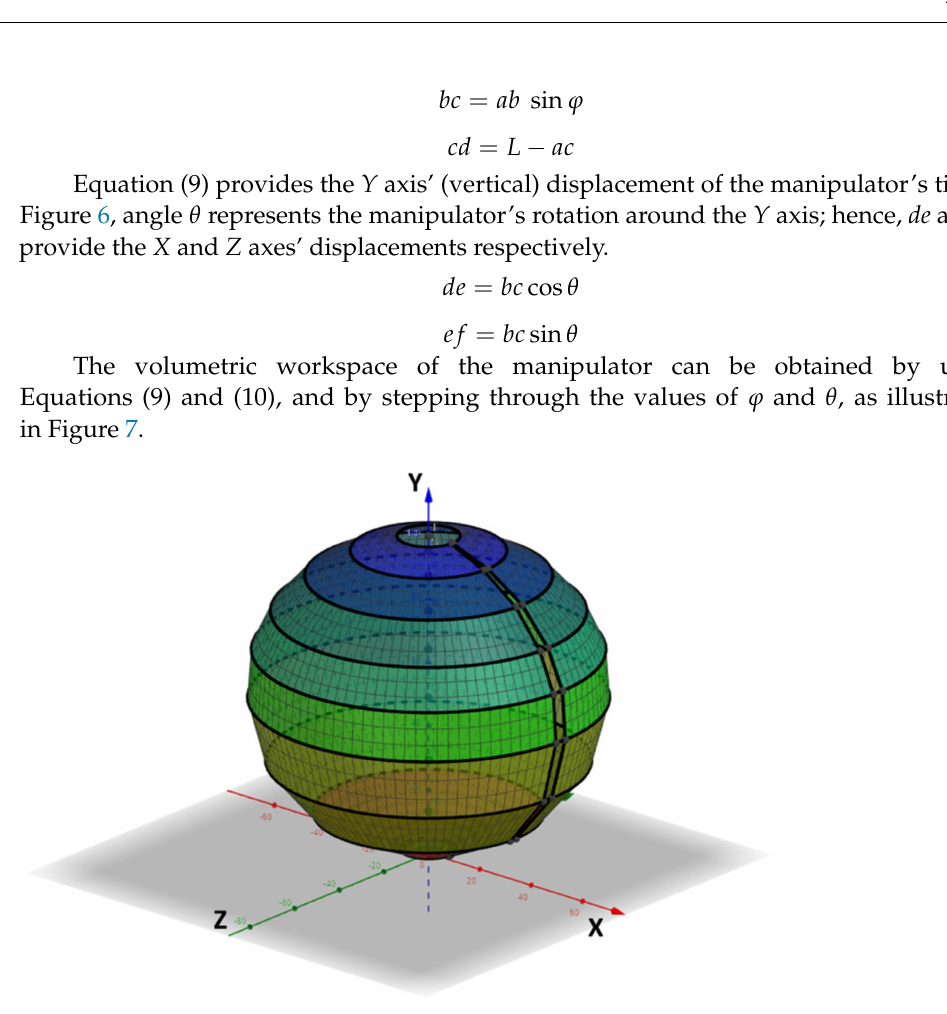
Figure 7. The manipulator’s volumetric workspace based on the mathematical model